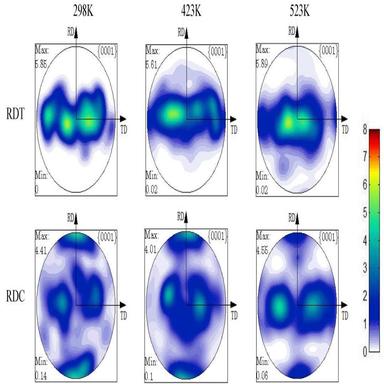
The (0001) pole figures of the α-Ti tube after 20% tension/compression deformation along the RD, showing that the textures change slightly in tensile deformation, but turn into the coexisting states of both the rolling texture and the bimodal texture in compressive deformation.